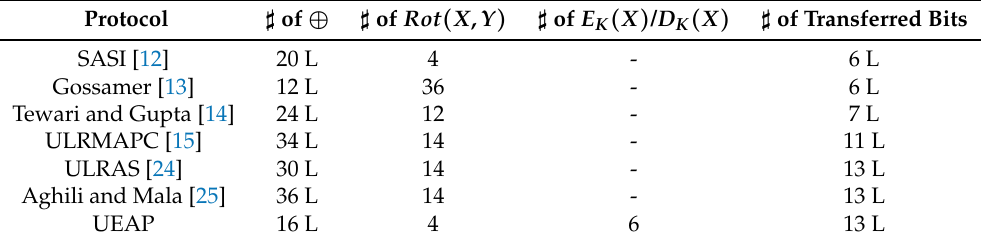
Table 4. Computational cost comparison of the UEAP protocol with other protocols, where L denotes the length of each parameter in